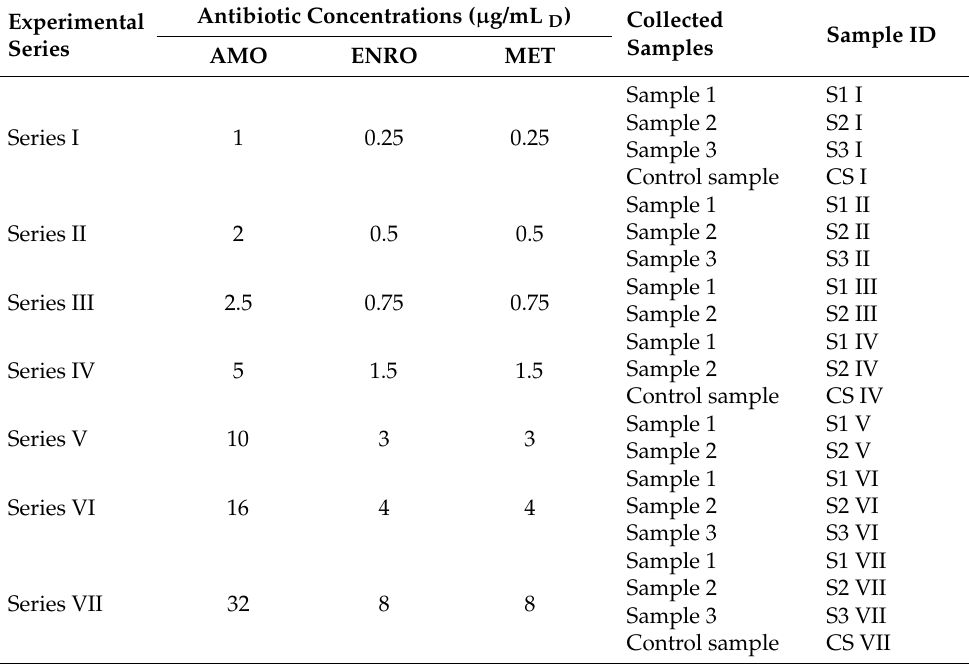
Table 2. Antibiotic concentrations ( µ g/mL D ) and ID numbers of the samples collected from the experimental reactor (experimental series I–VII) and the control reactor (CS) without